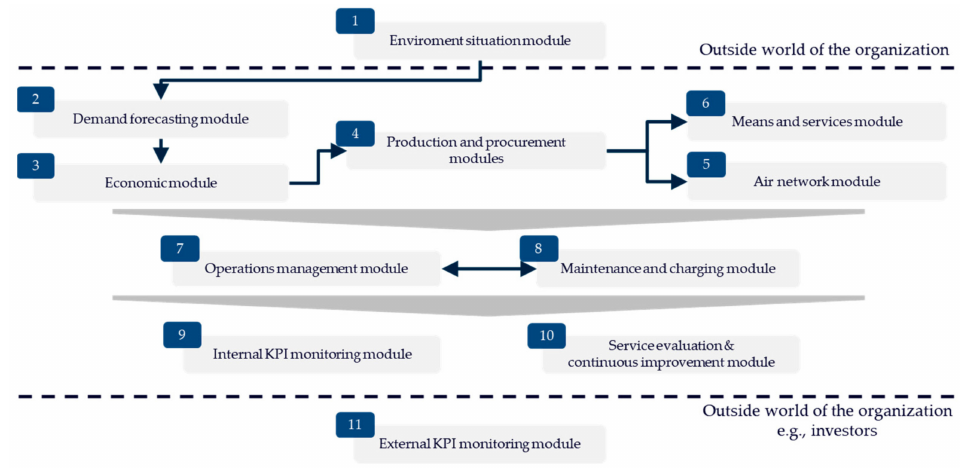
Figure 5. Conceptual Model for Electric Air Mobility Operations